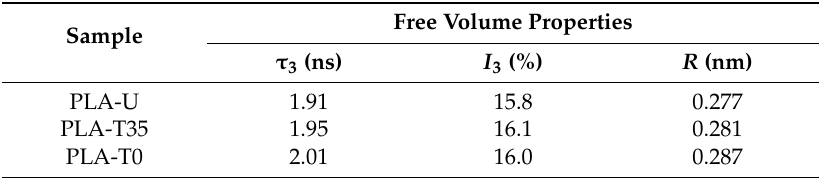
Table 2. Summary of free volume properties of PLA-U, PLA-T35, and PLA-T0